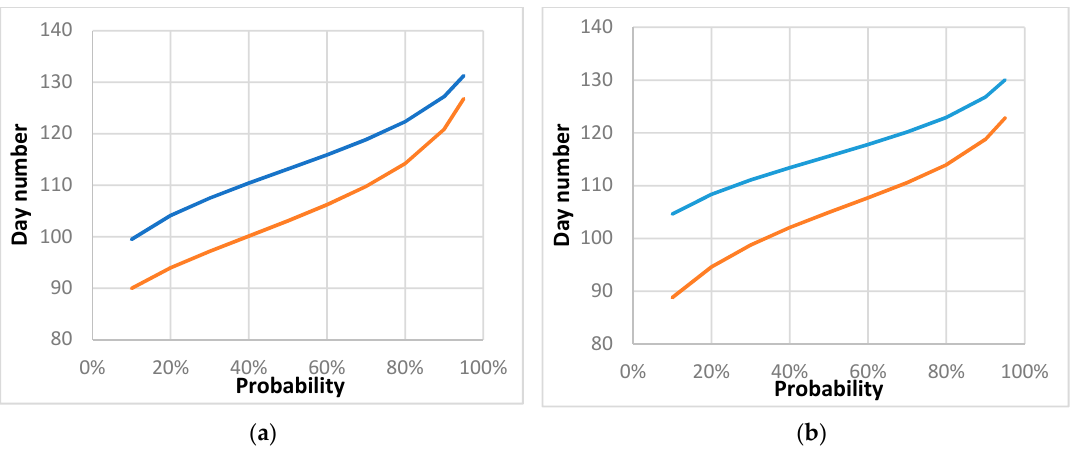
Figure 3. The probability curves of the last spring frost event described by a calendar day number (Tmin < 0 °C) in the period of 1961–1990 (blue line) and 1991–2020 (orange line). ( a ) Sandomierz ( b ) Kalisz.